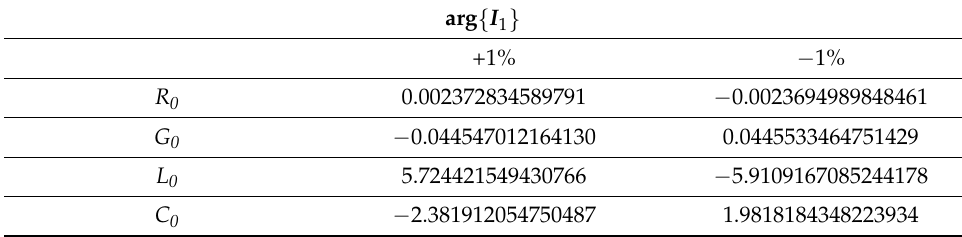
Table 7. Changes to the argument of the current I 1 .